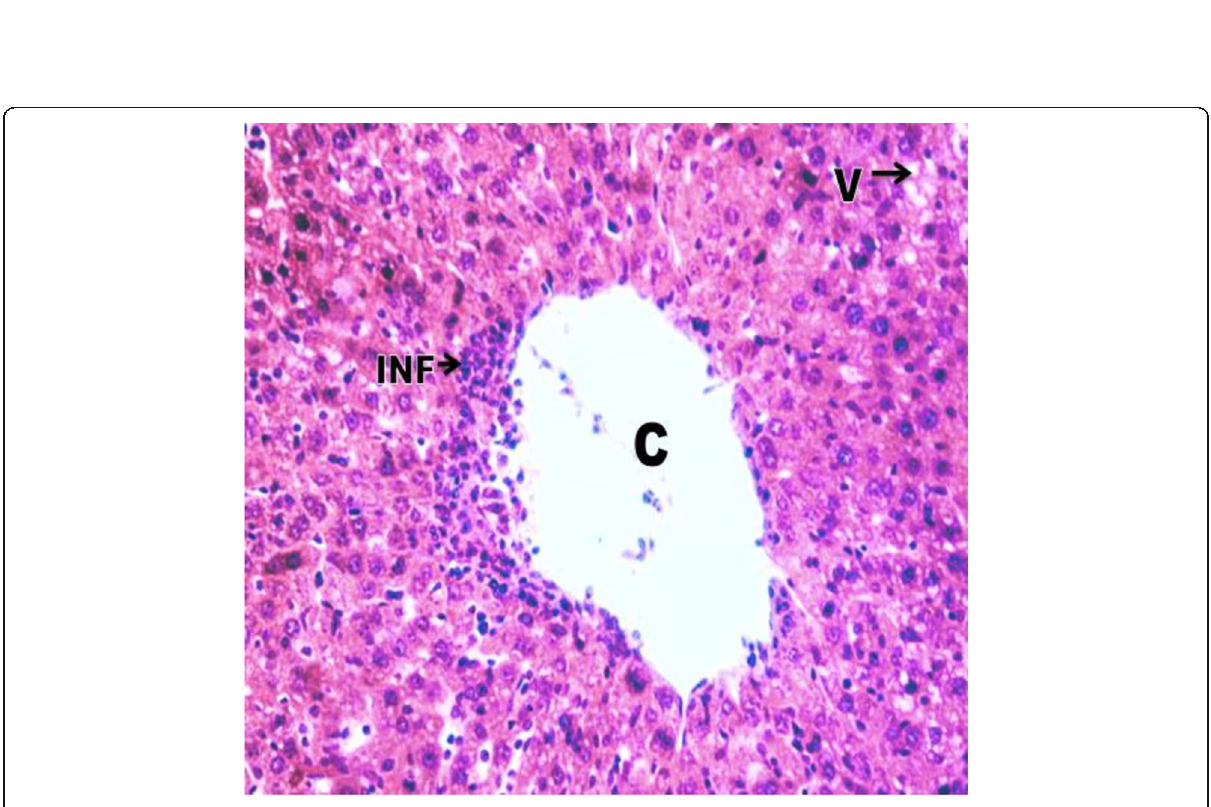
Fig. 3 Photomicrograph of a section of the liver of treated mouse with Tamiflu (16 mg/kg b.wt.) for 5 days showing hepatocytes with cytoplasmic vacuolation (V), inflammatory cells (INF), and damage of endothelial lining of central vein (C). (H&E, × 400)